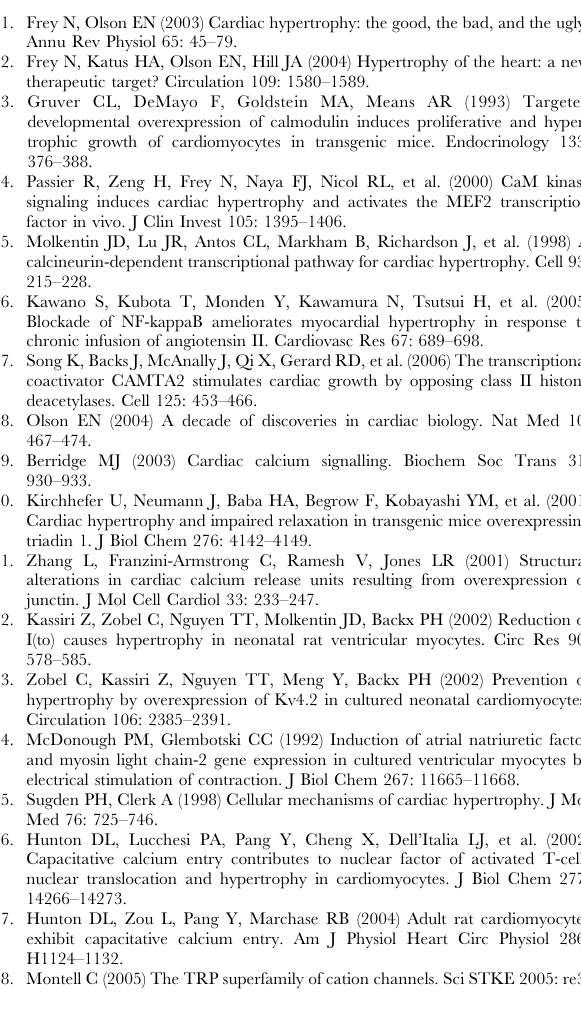
Table S1 PCR primers used for the production of the d-siRNA library.